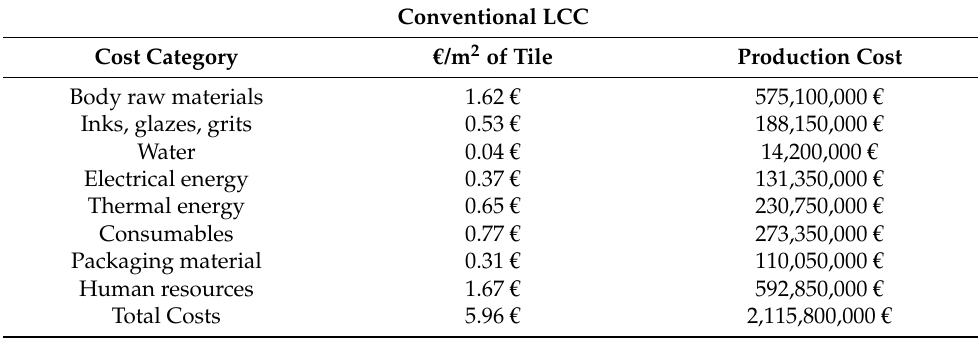
Table 2. Conventional LCC analysis (industrial costs).